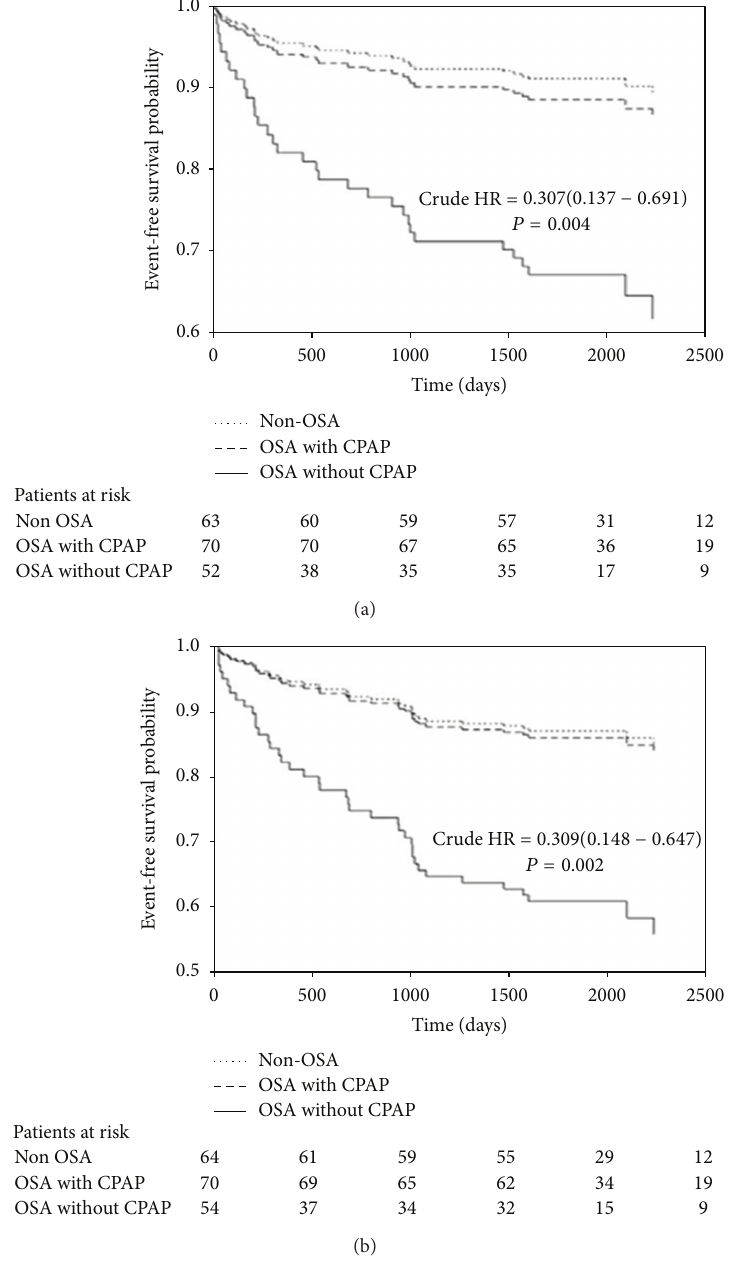
Figure 2: Time until first recurrent myocardial infarction (a) or revascularization procedure (b) in the three groups of MI patients. Crude hazard ratio (HR) of treated versus untreated OSA is presented, reproduced from Garcia-Rio et al. [55].